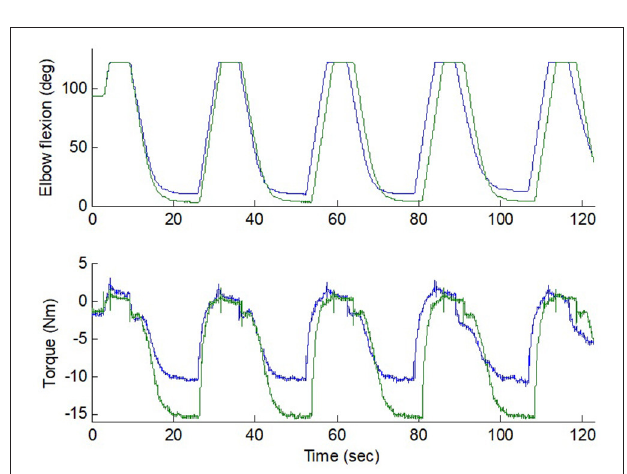
FIGURE 3 | Flexion and torque during two stretching trials (10Nm and 15Nm peak torque) in an elbow with strong spasticity. The stretching velocity was reduced gradually down to 0 as the resistance increased. Position limit was reached at the extreme flexion. The blue and green lines represent the flexion angle and torque changes at 10Nm and 15Nm peak